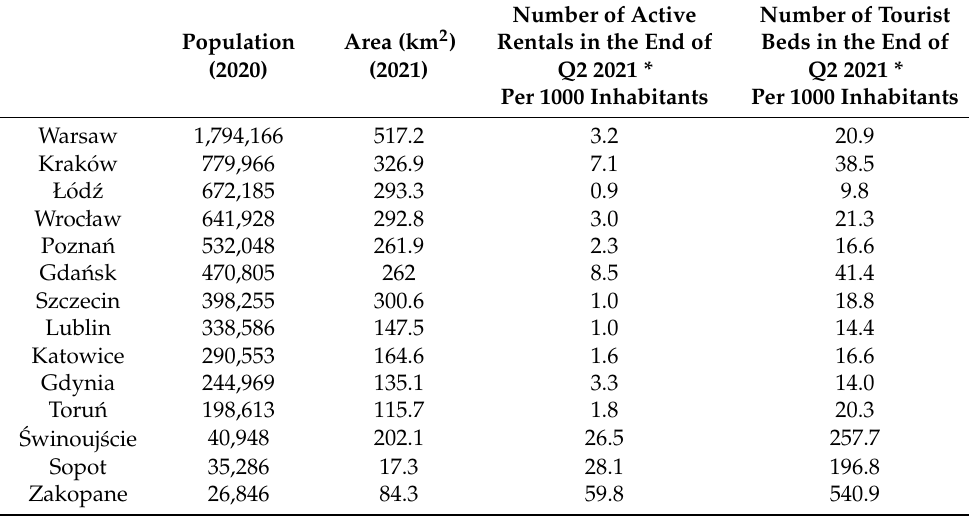
Table 2. The analyzed cities ranked according to the number of